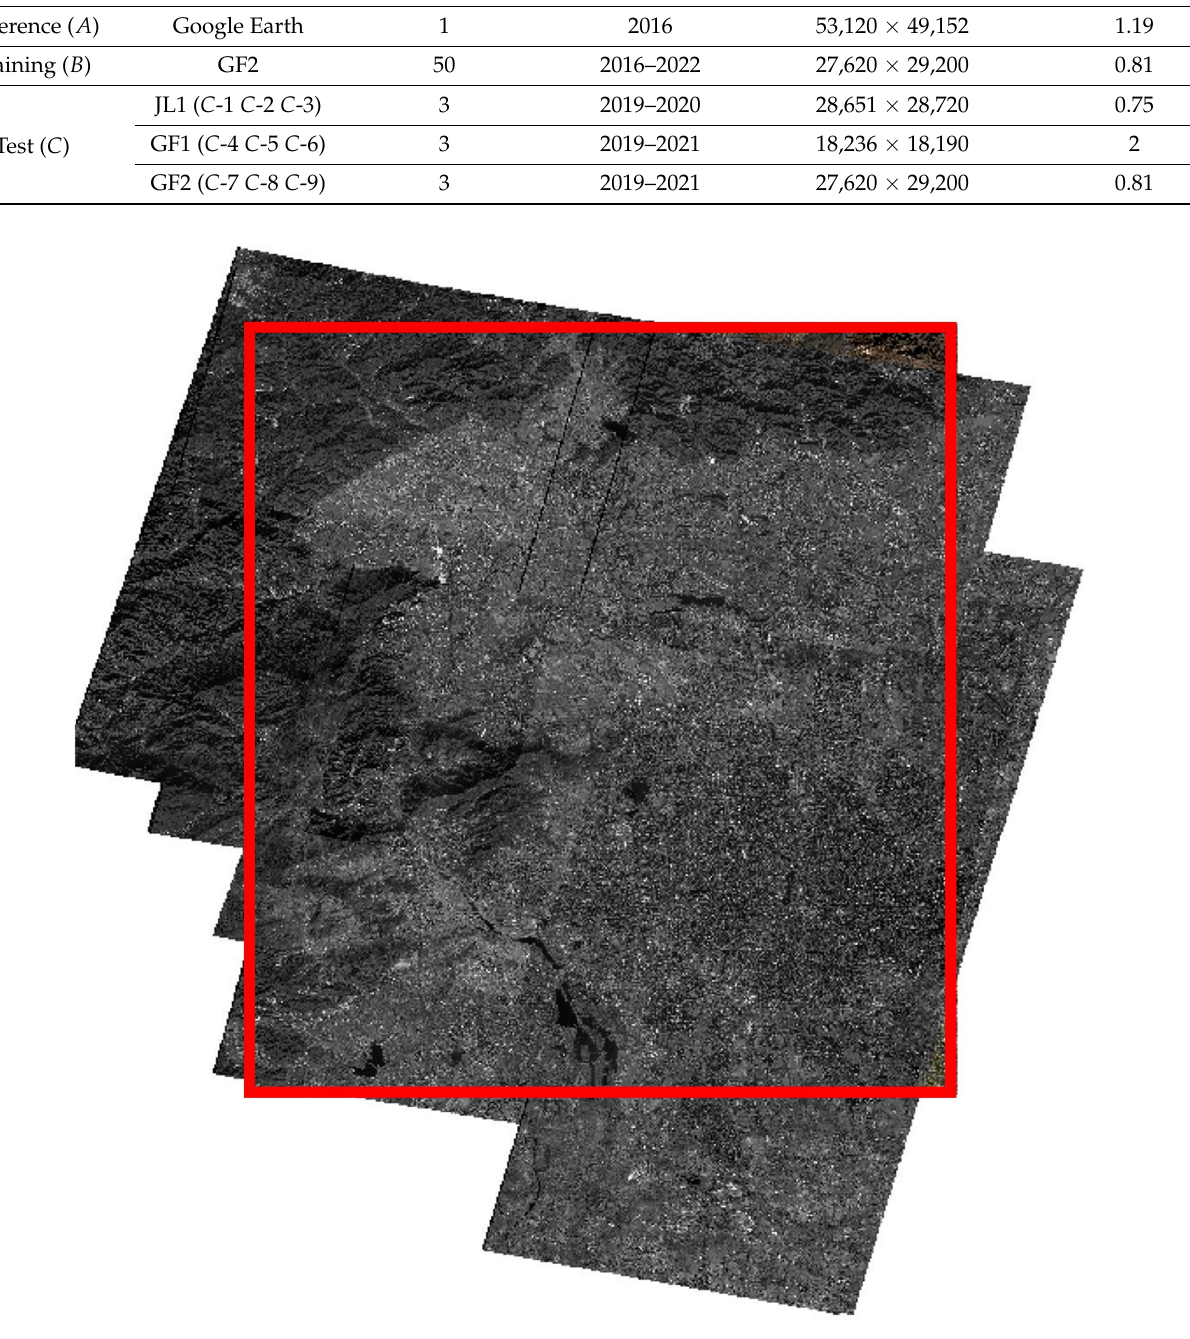
Figure 3. Diagram of the data